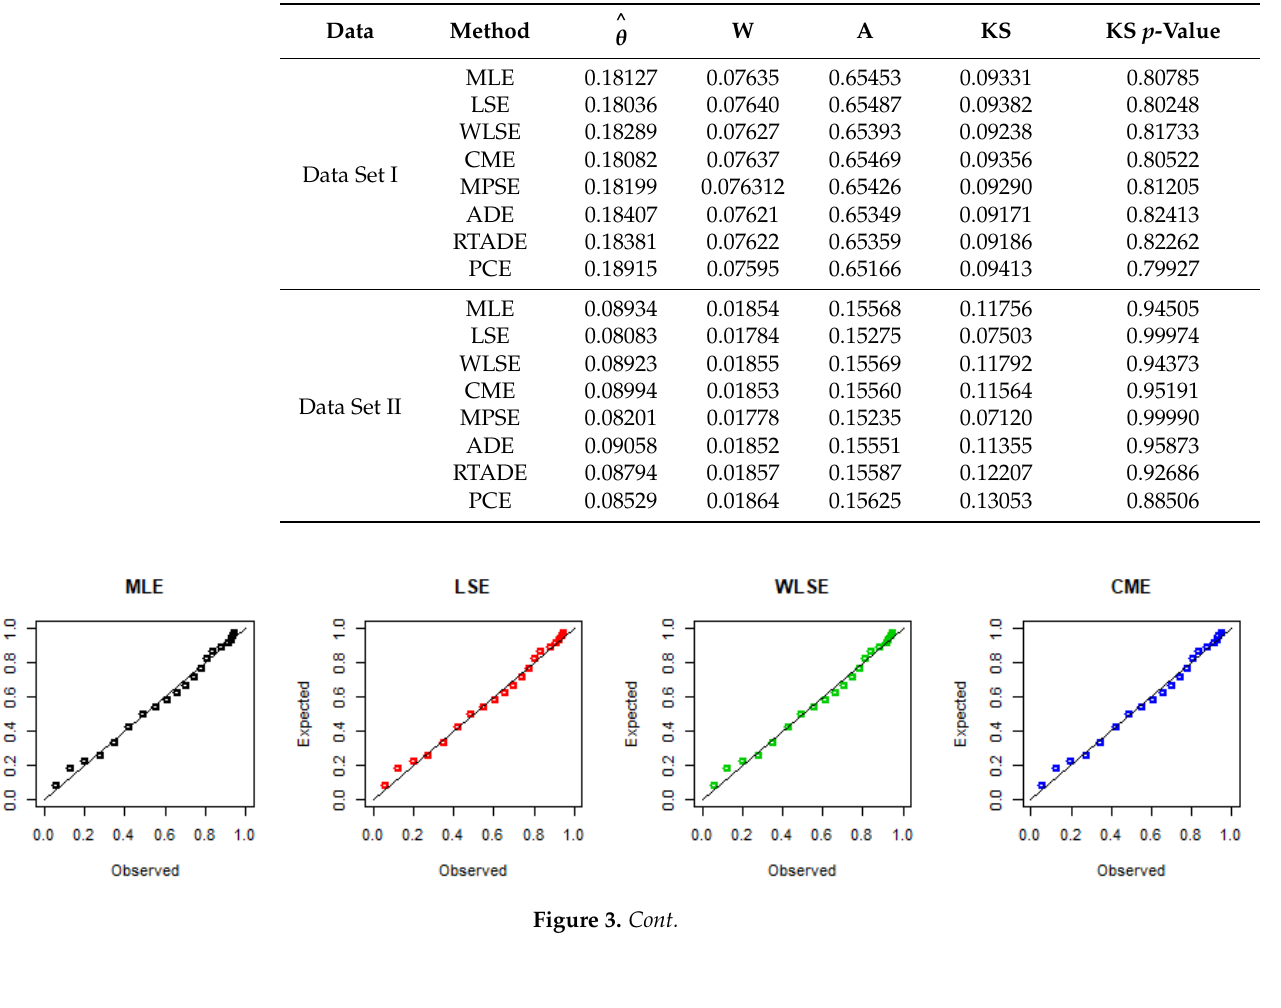
Table 7. Fitted estimates for COVID-19 and remission times data.